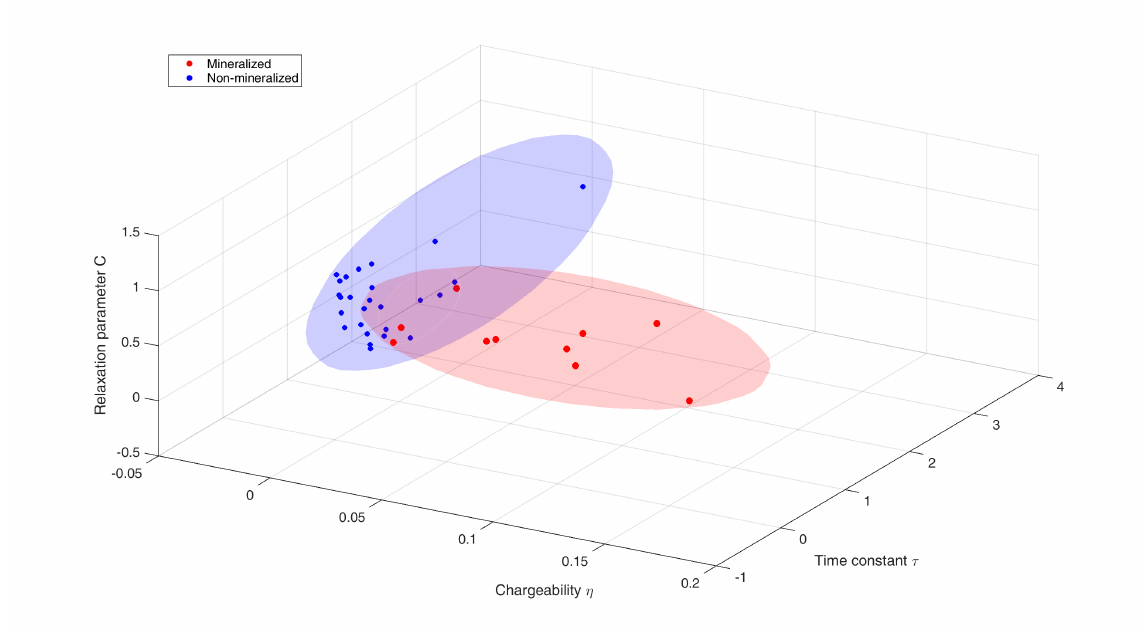
Figure 16. A 3D cross plot between the chargeability, time constant, and relaxation parameter. The target mineralized zones can be specified using the range of red